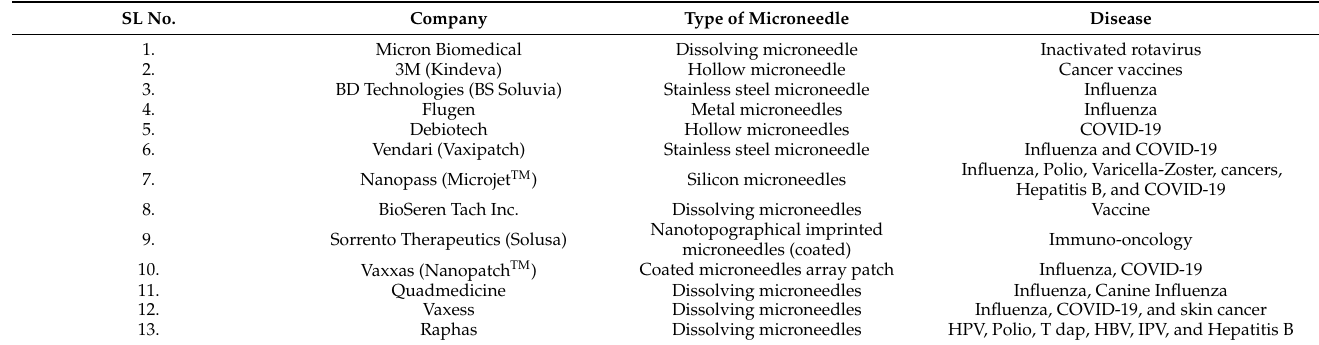
Table 11. Companies developing microneedles for vaccine